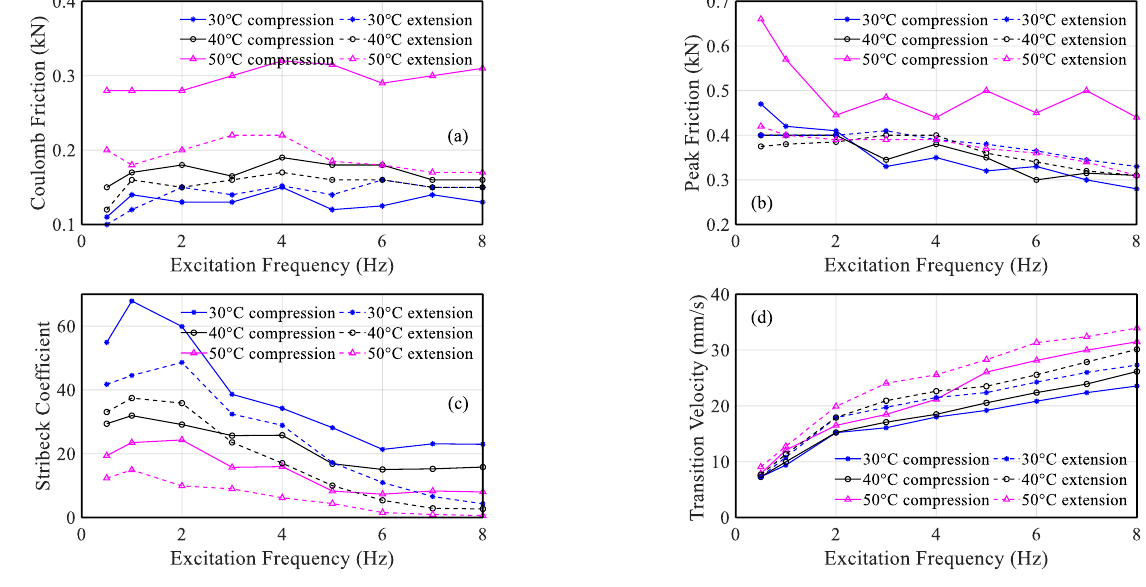
Figure 11. Variations in seal friction properties: ( a ) Coulomb friction, ( b ) peak friction, ( c ) Stribeck coefficient, and ( d ) transition velocity.